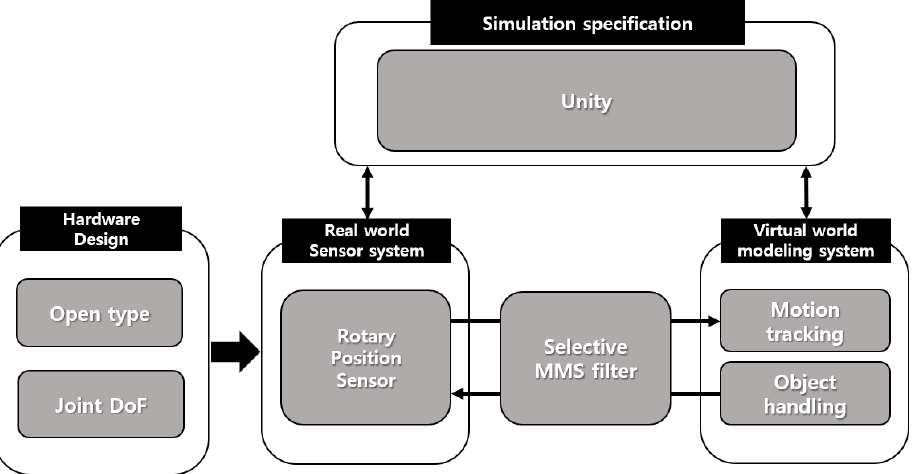
Figure 2. System overview of the proposed haptic